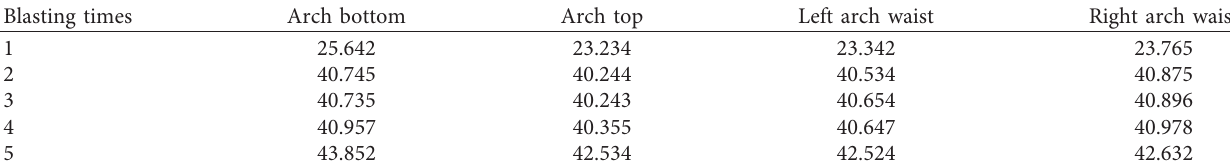
Table 2: Peak displacement at each measuring point of 1-1 profile (mm).